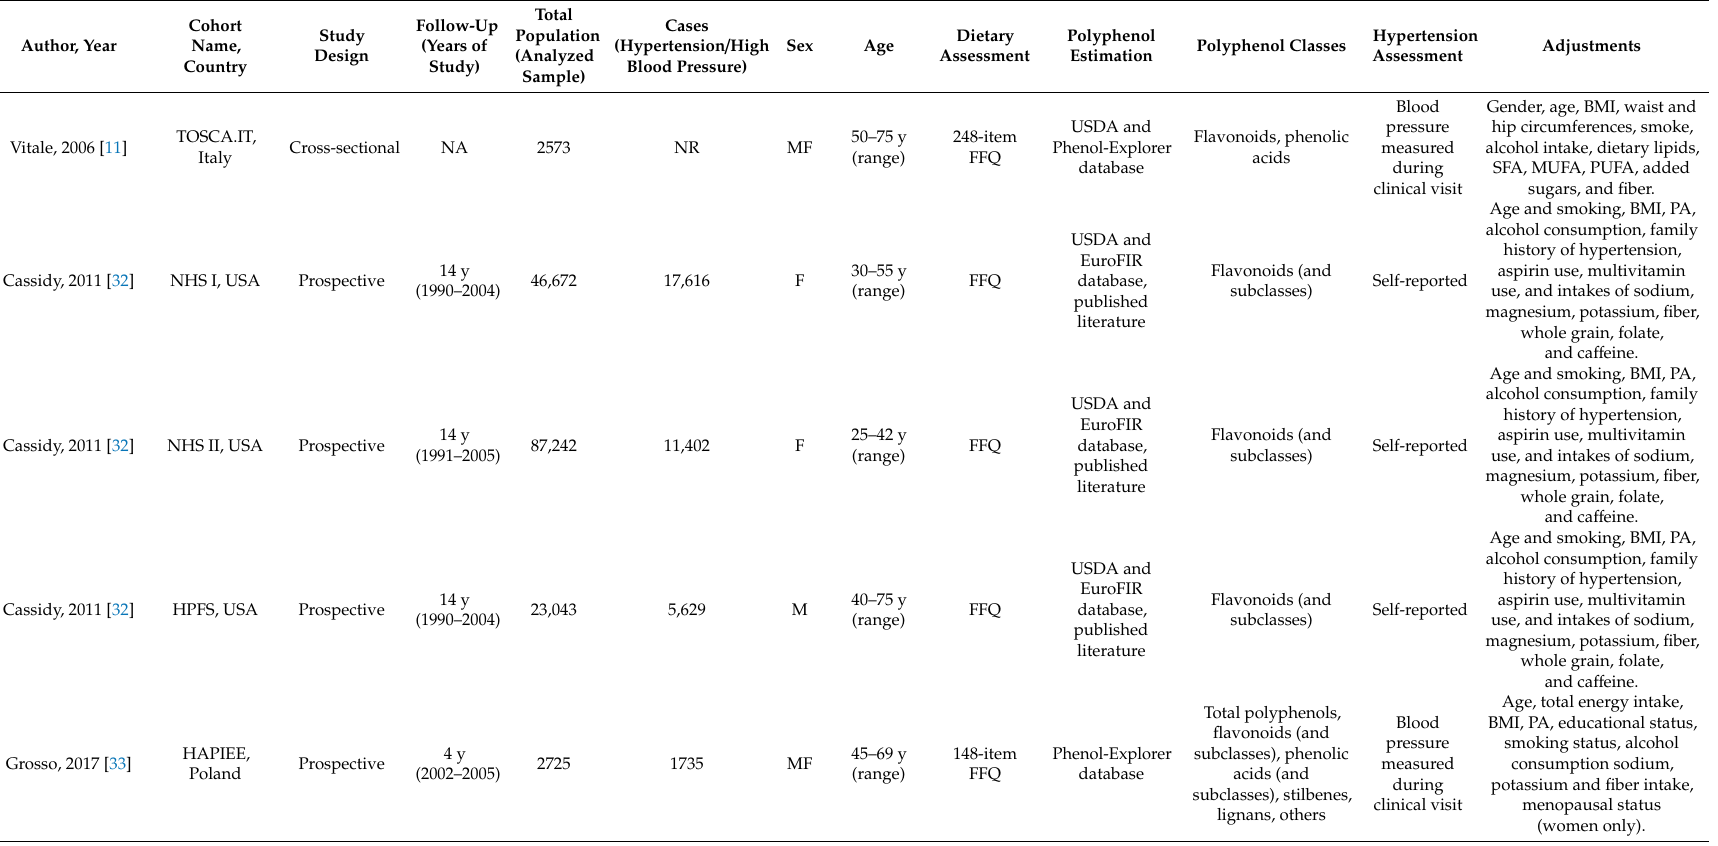
Table 1. Characteristics of prospective cohort studies investigating the relation between dietary polyphenol intake and blood pressure /